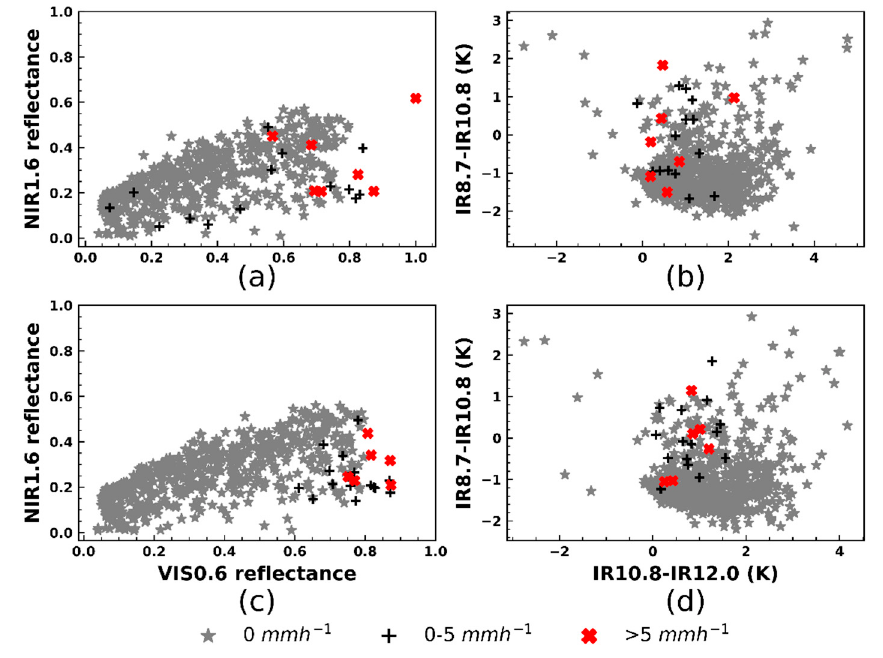
Figure 7. Day time R RG ( a , b ) and R MWL ( c , d ) as a function of VIS 0.6 µm versus NIR 1.6 µm ( a , c ), and ∆ T IR10.8-IR12.0 versus ∆ T IR8.7-IR10.8 ( b , d ) for